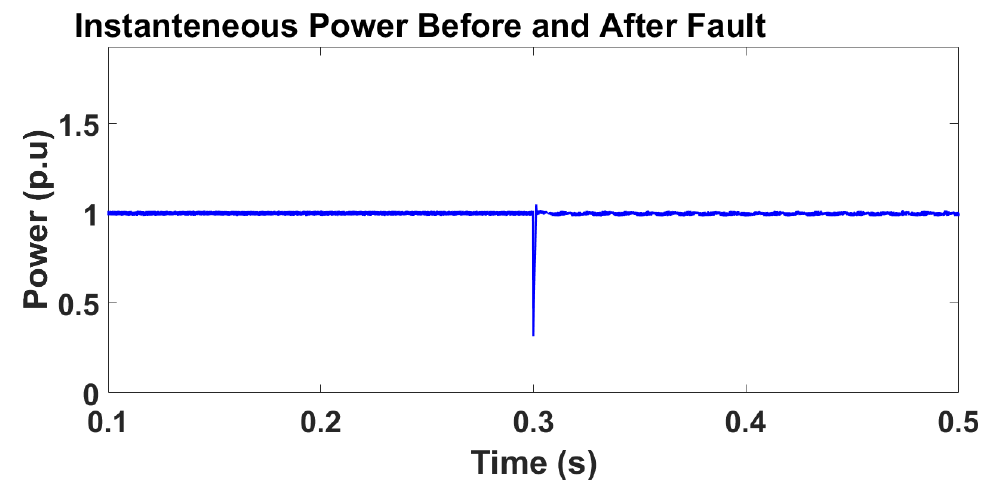
Figure 10. Instantaneous power flowing to grid before and after fault, using proposed